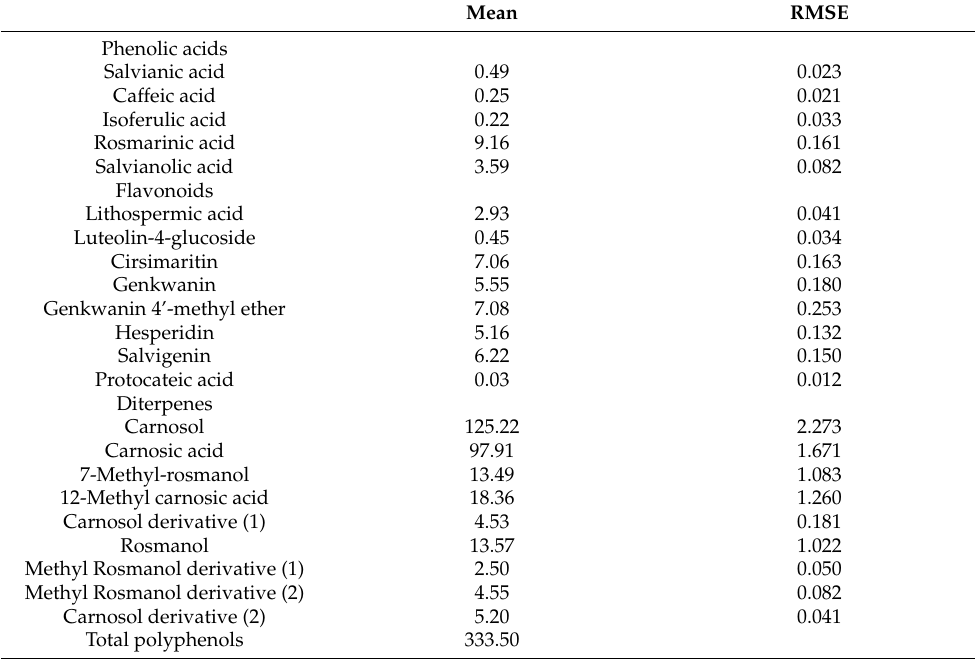
Table 2. Polyphenol content (mg/g) of rosemary lipophilic extract.